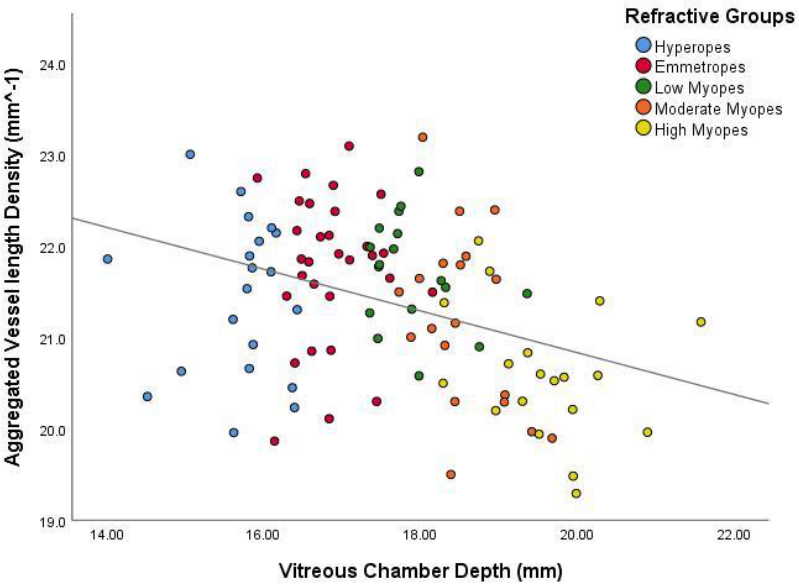
Figure 5. Scatter plot demonstrating the relationship between aggregated vessel length density and vitreous chamber depth. The colours distinguish the subjects for their particular eye size bin. The regression line indicates a significant inverse relationship (r 2 = 0.134, p < 0.001).